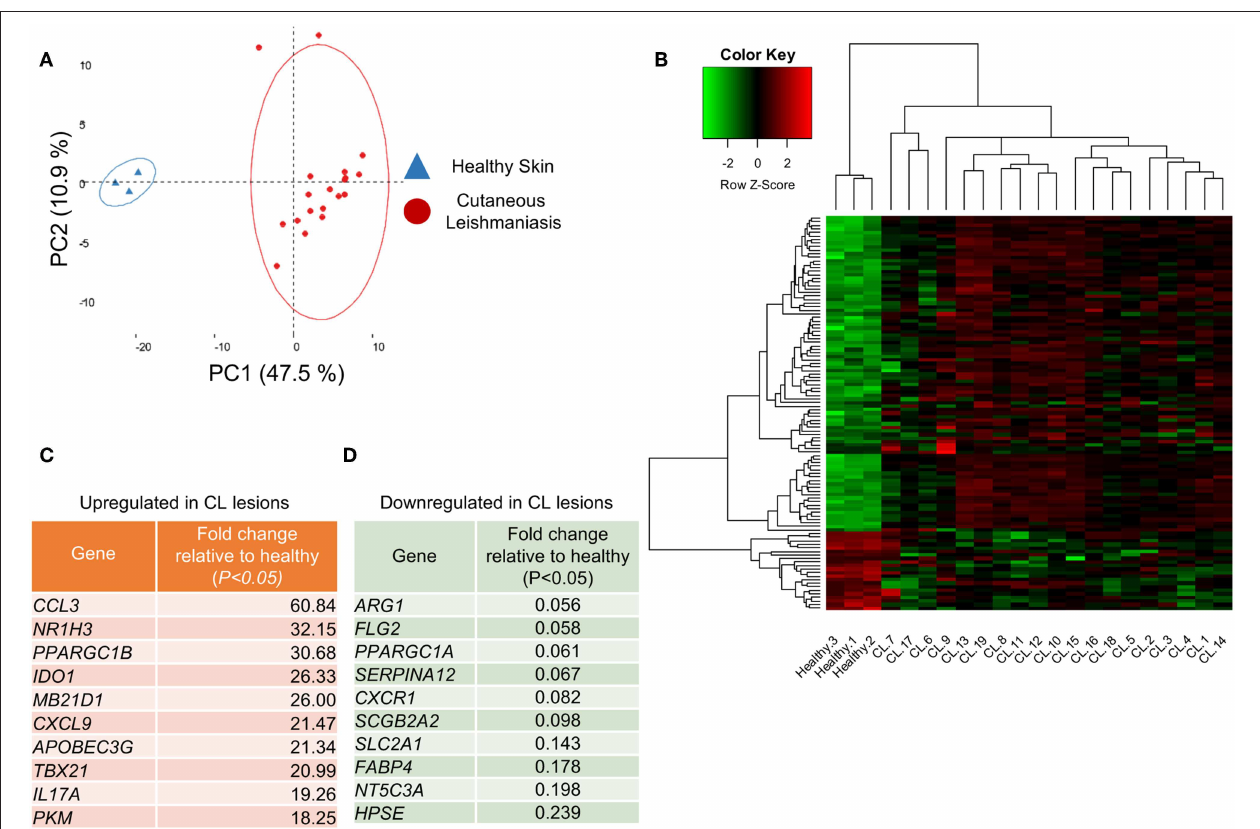
FIGURE 1 | Healthy skin is transcriptionally distinct from cutaneous leishmaniasis lesions. (A) PCA analysis of the 170 analyzed genes from the 22 skin biopsies from either healthy skin (blue triangles) or CL patients (red dots). The two principal components (PC) are displayed on the axis along with the variance. Large circles denote the 95% confidence level. (B) Clustered heatmap of skin biopsies from CL patients according to their differential gene expression of healthy skin and CL lesions. (C) Table detailing the 10 most upregulated genes in CL lesions compared to healthy skin. (D) Table detailing the 10 most downregulated genes in CL lesions compared to healthy